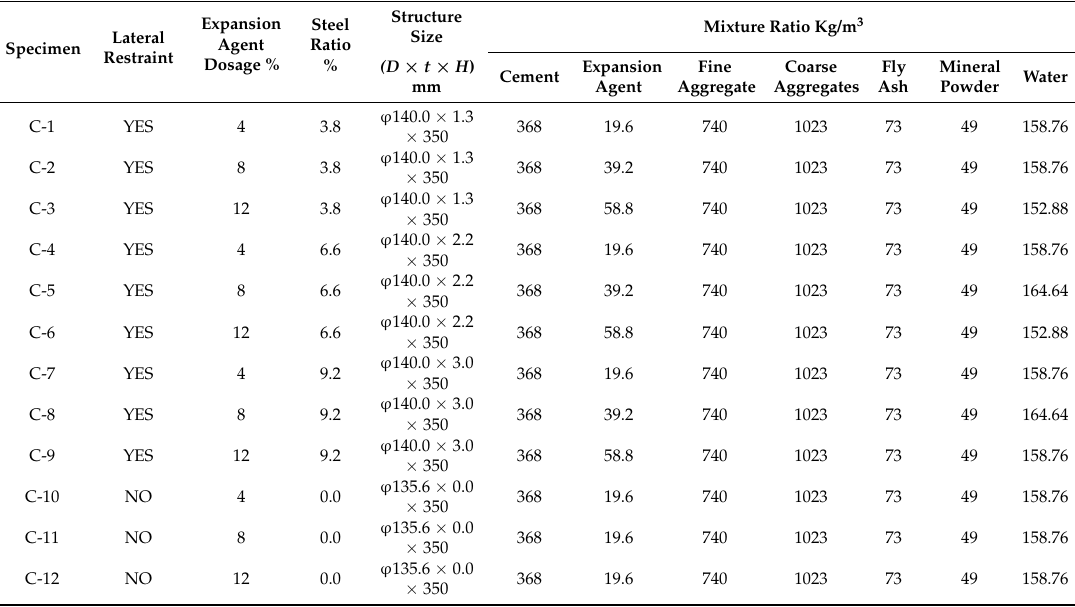
Figure 2. Example of a creep test on the specimen with lateral restraint.